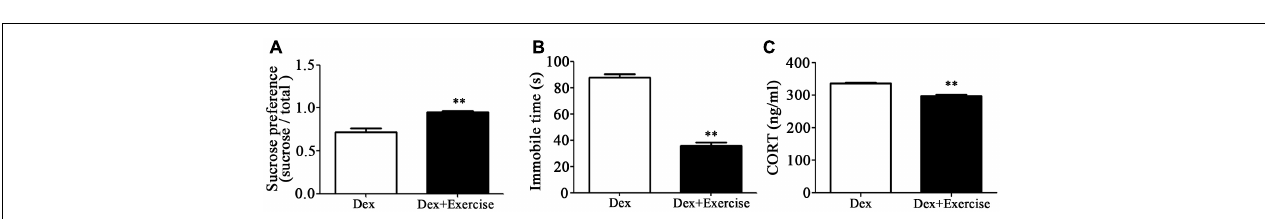
FIGURE 4 | ICV administration of MitoTEMPO improves depression-like behavior and reduces circulatory corticosterone level in Dex offspring. Male Dex offspring received ICV administration of MitoTEMPO (0.02 or 0.2 µ mol/kg, 5 µ L/day) for 4 days. Sucrose preference test (A) , FST (B) and corticosterone concentration in blood (C) were then determined. Data are presented as means ± SEM ( n = 6/group). ∗∗ P < 0.01 vs. control.